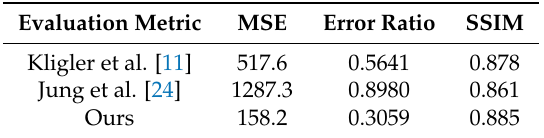
Table 2. Quantitative comparisons of our method and some state-of-the-art approaches for the HS dataset with evaluation metrics MSE , Error Ratio , SSIM .